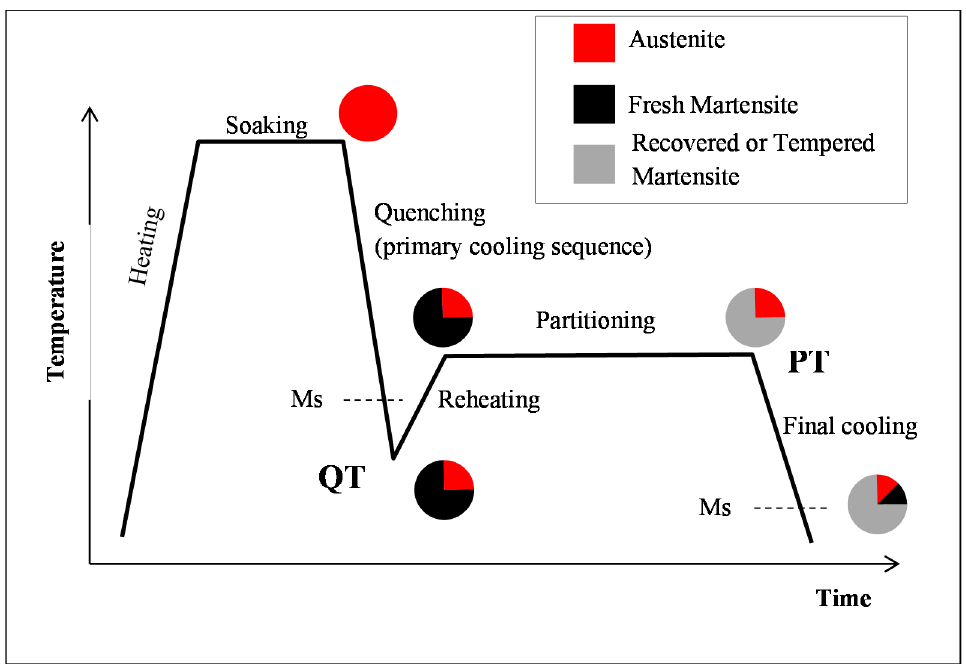
Figure 1. Typical time–temperature scheme to produce Quenching & Partitioning (Q&P) Transformation Induced Plasticity (TRIP) steels after a full austenitic soaking, and corresponding microstructures, according to [4–6]. The quench temperature (QT) and the partitioning temperature (PT) characterizing the cycle are positioned on the cycle.